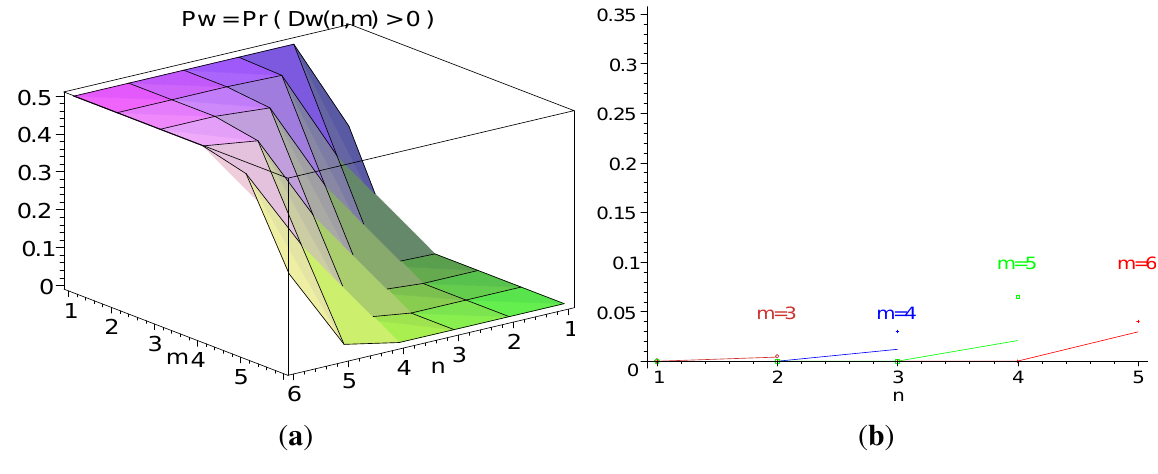
, 3D and 2D representation of P 2